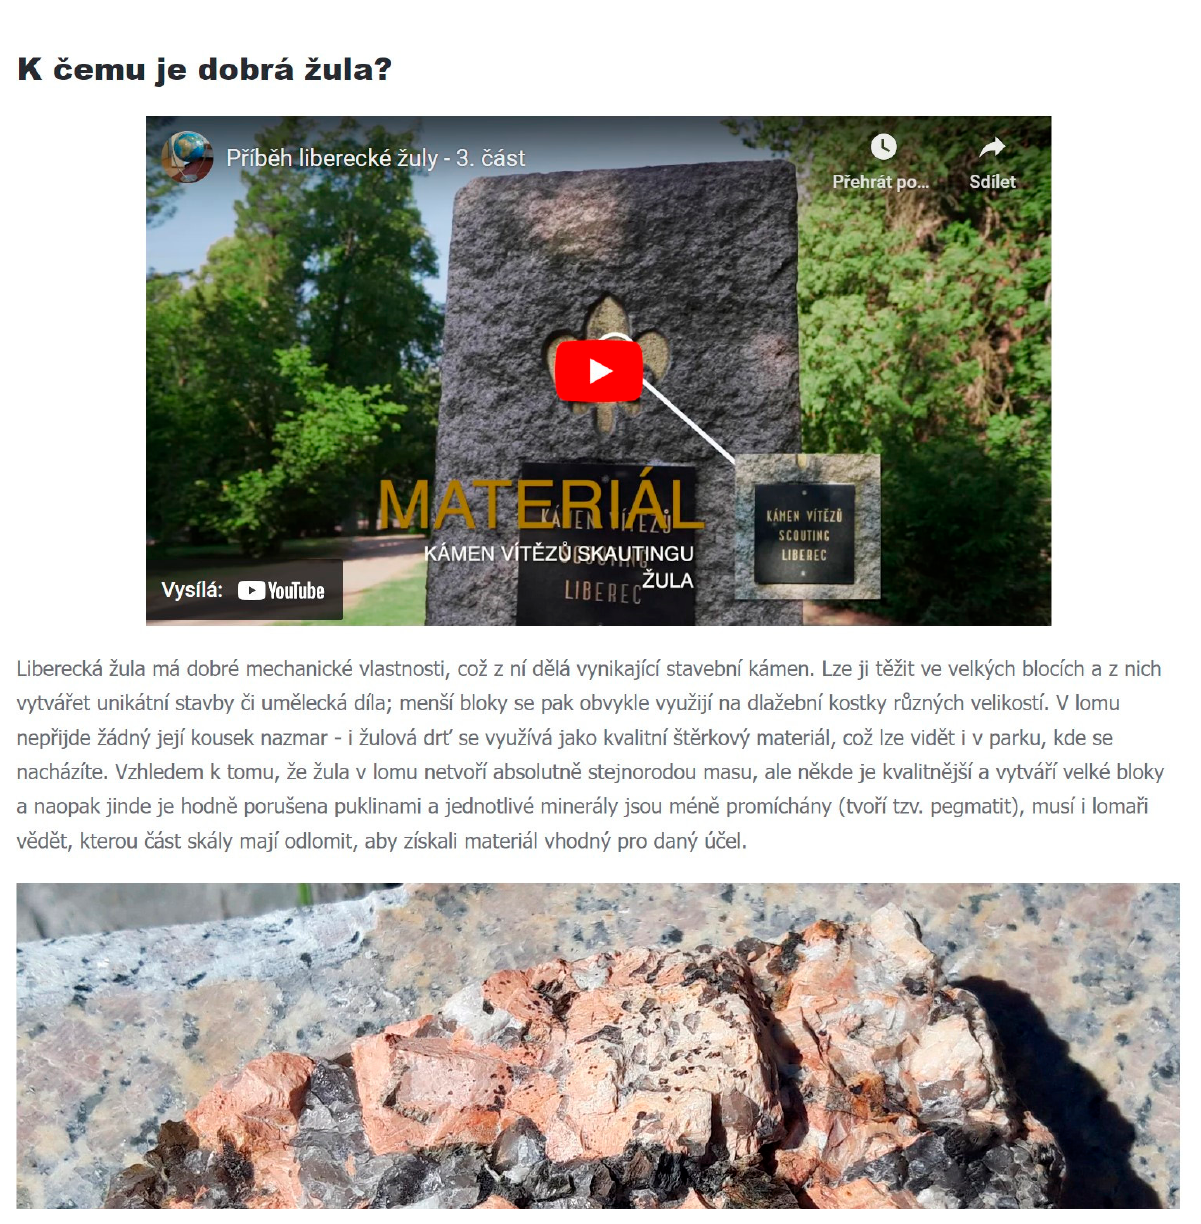
Figure 5. Example of a stop on the geotrail “The Story of Liberec Granite”—at the top of the page there is an introductory video, followed by text with pictures. For translation, see Appendix A (Location 3).